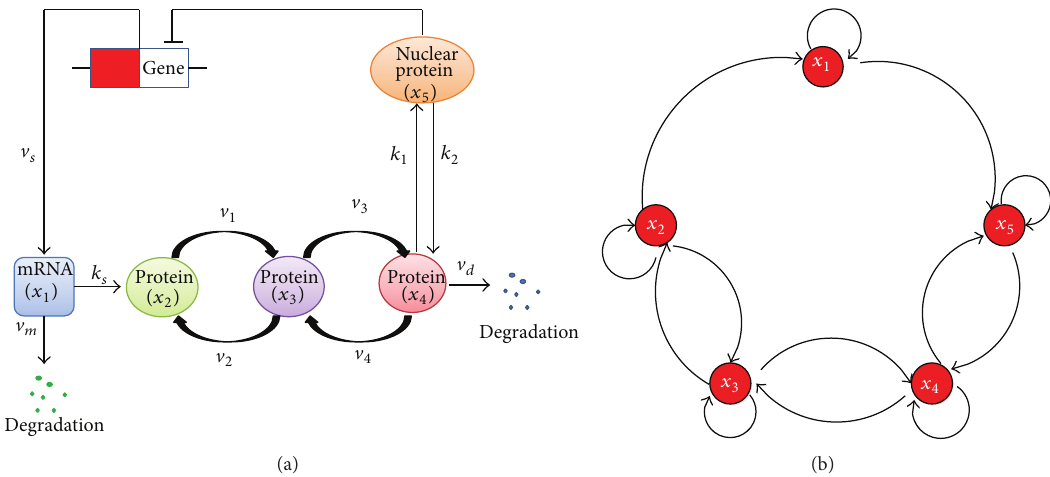
Figure 1: (a) A core model for circadian rhythms [7]. Parameters marked on the directed edges denote reaction rates. 𝑥 1 denotes the concentration of the mRNA; 𝑥 2 , 𝑥 3 , 𝑥 4 , and 𝑥 5 are the concentrations of four forms of the protein expressed by the gene; 𝑥 2 ,𝑥 3 , and 𝑥 4 are cytosolic proteins; 𝑥 5 is nuclear protein. The circadian gene transcripts mRNA 𝑥 1 and then translates protein 𝑥 2 . Proteins 𝑥 2 , 𝑥 3 , and 𝑥 4 can be reversibly phosphorylated successively. 𝑥 4 can be transported into the nucleus; the nucleus protein 𝑥 5 can negatively regulate the expression of the circadian gene. The mRNA and protein 𝑥 4 suffer from degradations. (b) The inference diagram [4] for the circadian rhythm model (3). If 𝑥 𝑖 appears in 𝑥 𝑗 ’s differential equation, then there will be a directed edge from 𝑥 𝑗 to 𝑥 𝑖 .